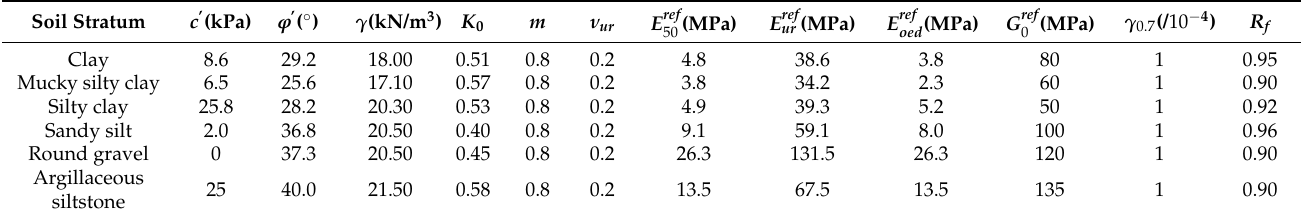
Table 2. Parameters of HSS model of soil layers.